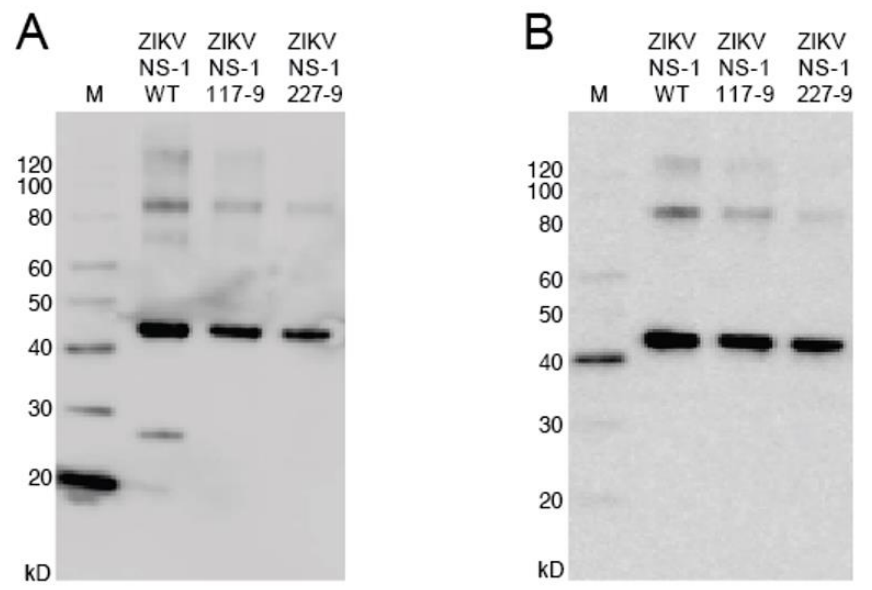
Figure 2. Western blot of NS1 mutants. ( A ): The blot was probed with anti-His6 antibody targeted toward the protein N-terminus. ( B ): The blot was probed with anti-ZIKV NS1 monoclonal antibody targeted toward the C-terminus. Uncropped gels are displayed in Figure S1.